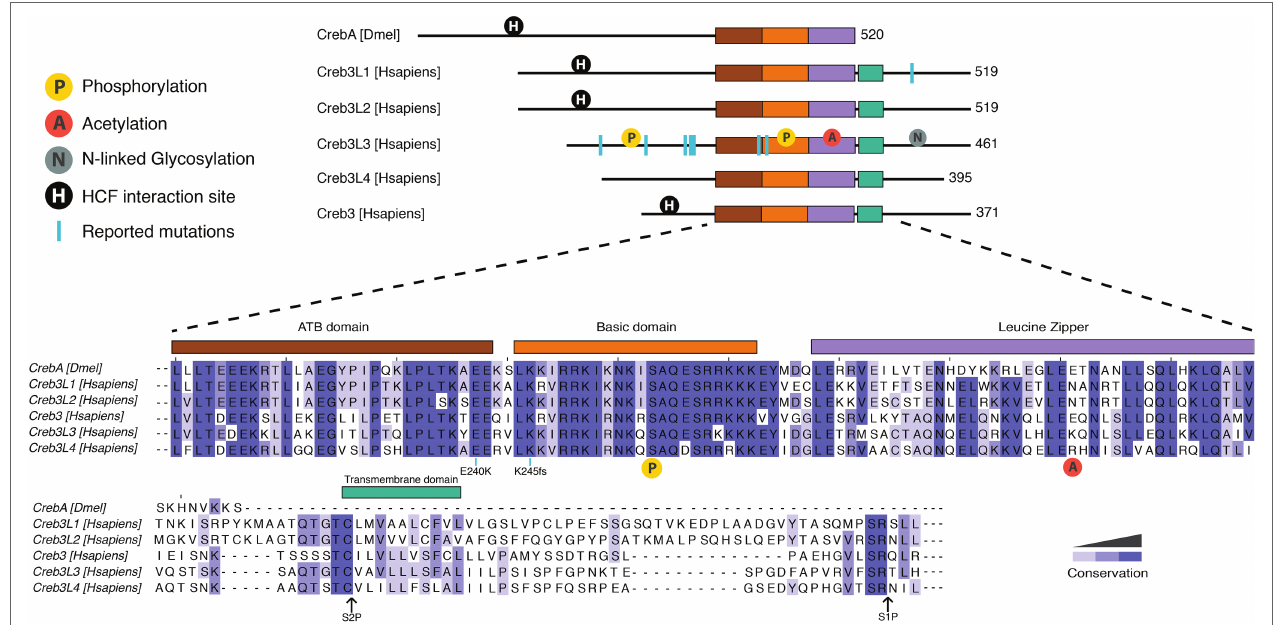
FIGURE 1 | Protein organization of human and Drosophila Creb3 transcription factor family. All proteins share the highly conserved adjacent to bZip (ATB) (shown in brown), basic (orange), and leucine zipper (purple) domains. CrebA lacks the transmembrane domain (green) that allows the human Creb3 proteins to dock on to the ER and subsequently get cleaved by serine proteases at the S2P and S1P sites. The N-terminal fragment is then imported into the nucleus, where it binds DNA. CrebA, Creb3L1, Creb3L2, and Creb3 contain an interaction site for HCF (shown in black circle). Creb3L3 is modified by a number of posttranslational modifications, including phosphorylation (yellow circle), acetylation (red circle), and N-linked glycosylation (gray circle). Phosphorylation in the basic domain (yellow circle shown under the sequences) is conserved in all proteins. Reported mutations for family members are marked by blue lines. A mutation found in human Creb3L1 is Tyr428 which leads to a premature stop codon. Reported mutations in Creb3L3 are W46X, G105R, P166L, V180M, D182N, E240K, and K245fs. K245fs is a complex mutation found in three unrelated individuals. The mutation includes an insertion of a G in the first nucleotide of the codon 245 with another A to T mutation in the codon 247 resulting a frame shift mutation leading to a stop codon at codon 374. Mutations E240K and 245fs are conserved throughout human Creb3 proteins and CrebA. Sequence alignment was performed using Clustal